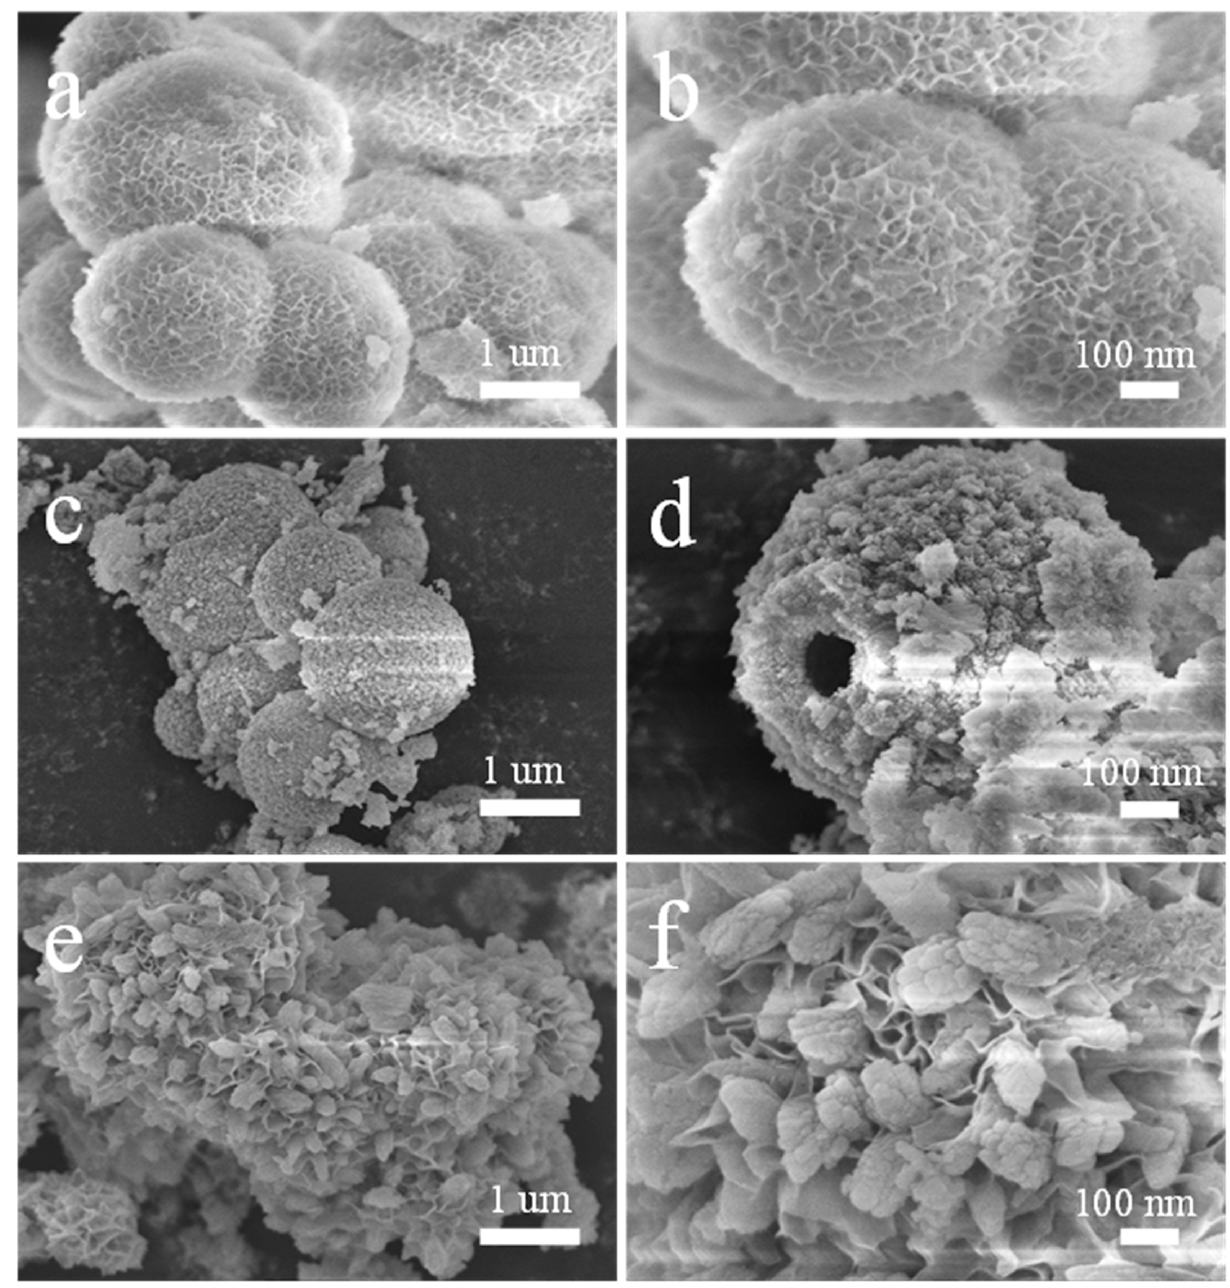
Figure 2. SEM images of the prepared NiMo-LDH ( a , b ), NiCo-MOF( c , d ), and NiMo-LDH@NiCo- MOFs ( e , f ) under different magnifications.